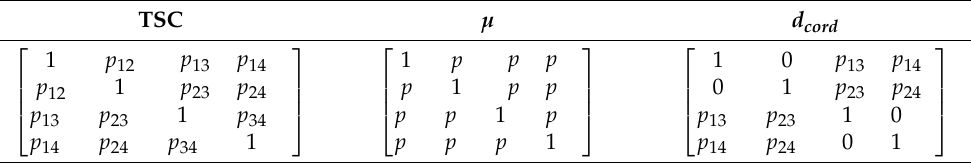
Table 2. Optimizations of various parameters, and relative impact on the Gram